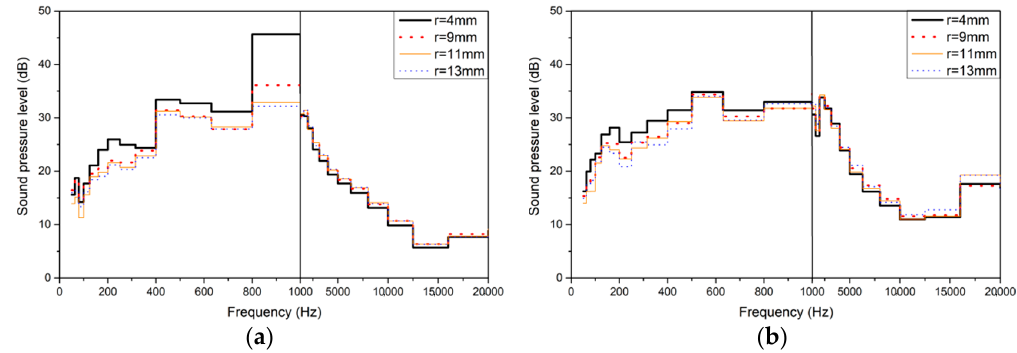
Figure 25. Noise spectrum: ( a ) Spectrum of 1/3 octave band of microphone-B; ( b ) Spectrum of 1/3 octave band of microphone-E.